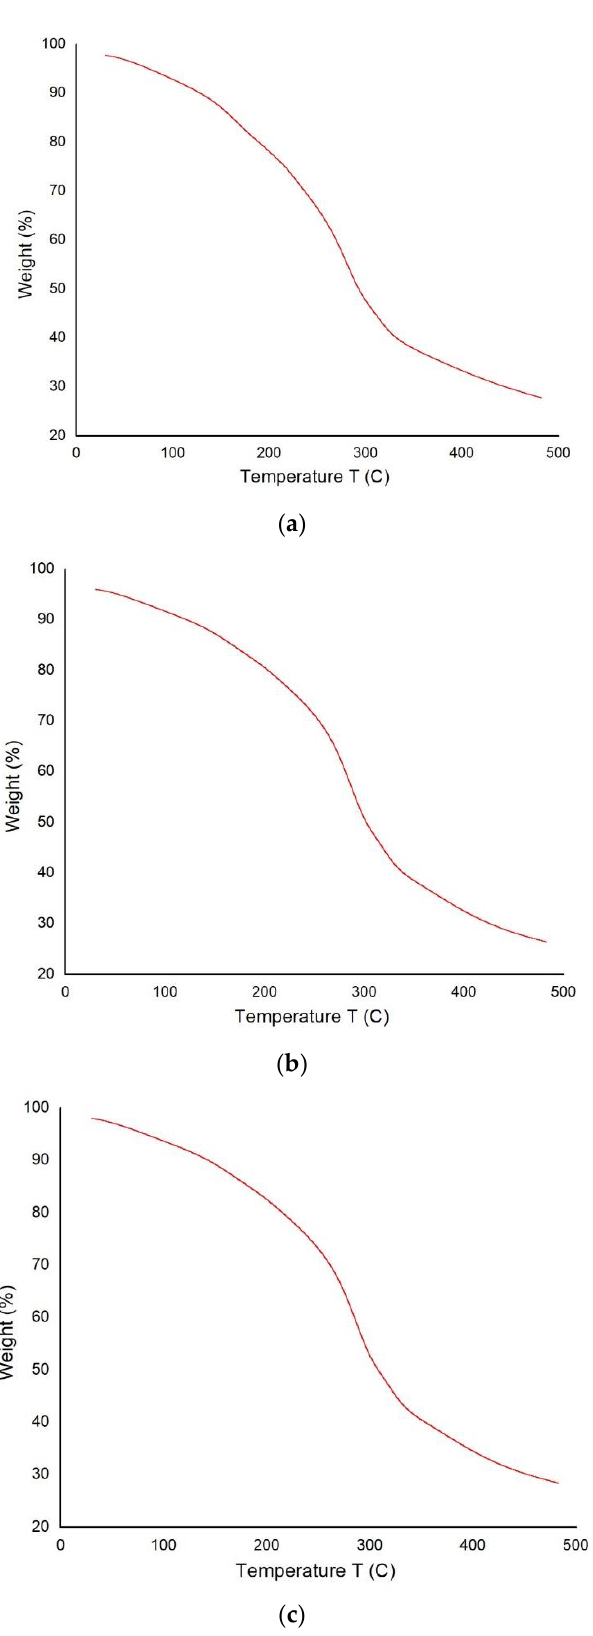
Figure 12. TGA analysis of the bio-composite samples at various ratios of fenugreek ( a ) 5% ( b ) 10% and ( c ) 15%.